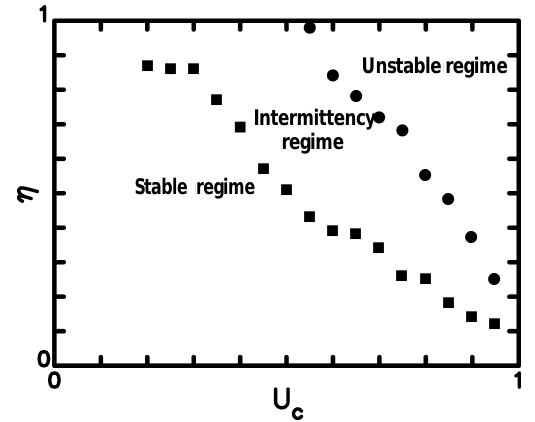
Figure 13. The plot of η l (with a solid square) and η u (with a solid circle) versus U c